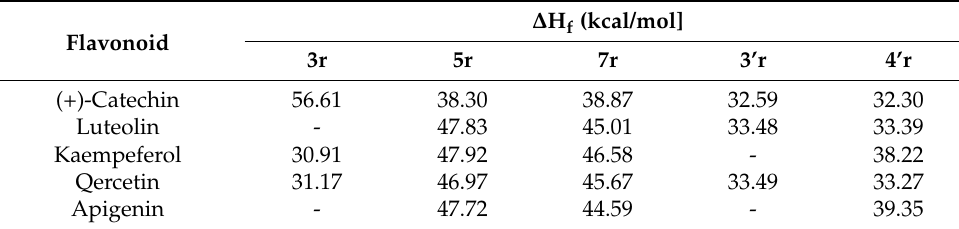
Table 5. Heat values of ∆ Hf formation of individual radicals for selected flavonoids. Luteolin and kaempferol do not create radicals in 3r and 3’r positions, respectively. Based on [116].